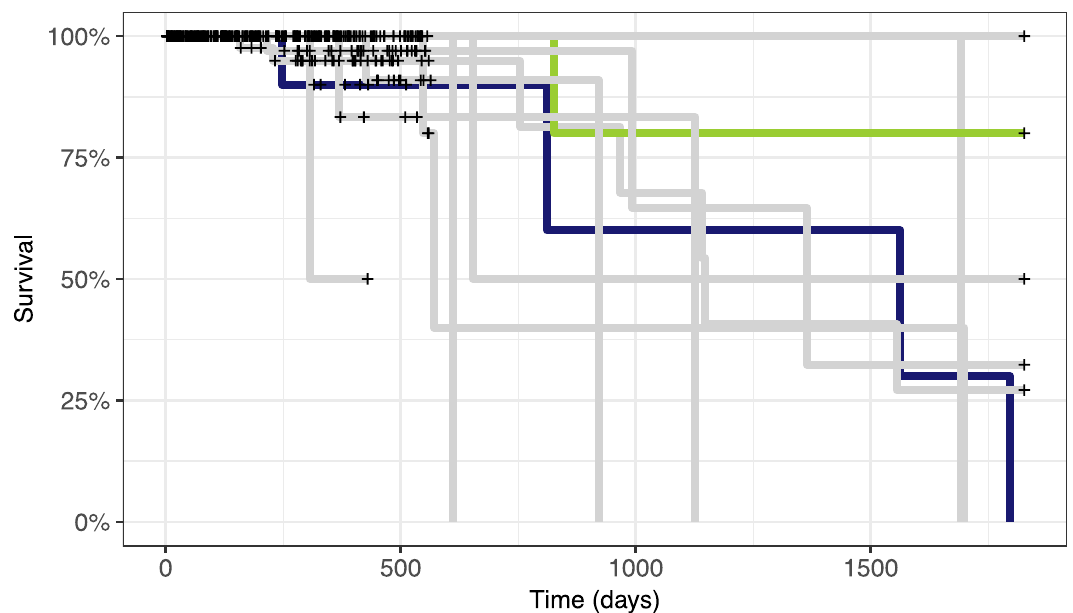
Fig 10. Survival curves for clusters in Fig 9. The highlightedclusters have different survival probabilities with p = 0.012 under the log-ranksurvival model.